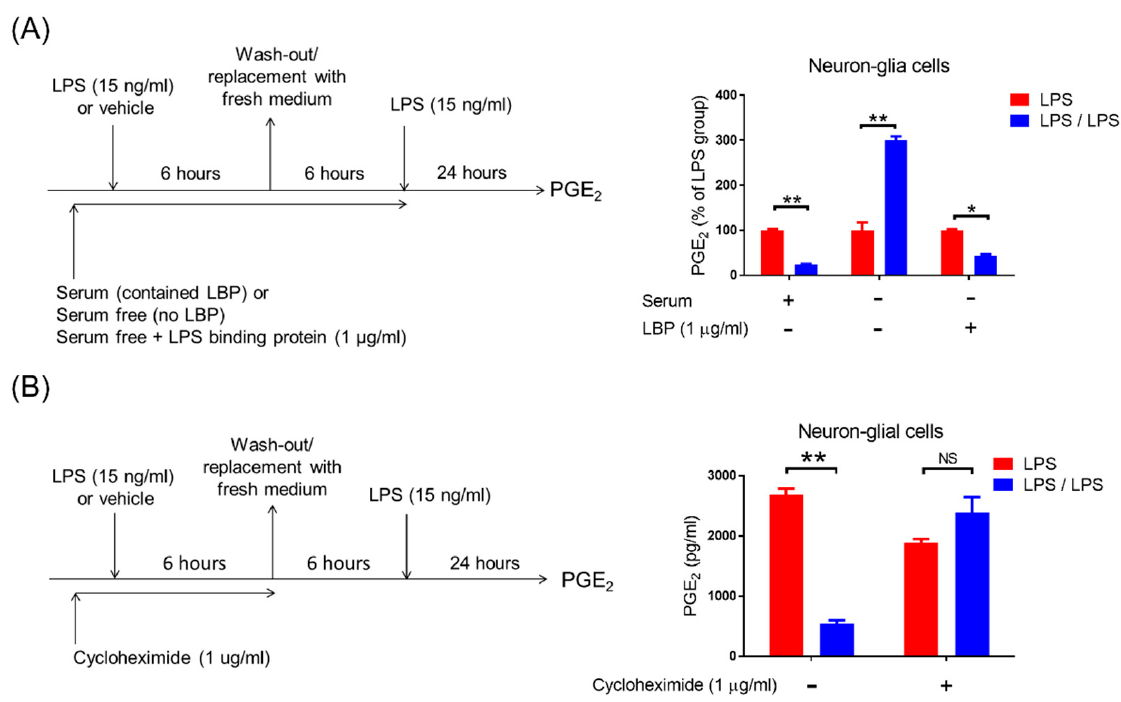
Figure 4. TLR4 signal and de novo protein synthesis is required for the development of PGE 2 tolerance in neuron–glial cells. ( A ) Left panel: Experimental procedure for studying the TLR4’s role in PGE 2 reduction during the endotoxin tolerance challenges. Right panel: Measurement of PGE 2 production in the NG cultures with or without endotoxin tolerance challenge (LPS-treated versus LPS/LPS-treated group) in the conditions of 10% serum medium, serum-free medium, or serum-free plus LBP (1 µ g/mL) at 24 h by ELISA. Data are expressed as the mean ± SEM from three independent experiments in duplicate, LPS group versus the LPS/LPS group. * p < 0.05, ** p < 0.01. ( B ) Left panel: Experimental procedure for studying the role of de novo protein synthesis in PGE 2 reduction in response to endotoxin tolerance. Right panel: After treatment with cycloheximide (1 µ g/mL) for 1 h, the NG cultures were applied to the procedure of the endotoxin tolerance challenge (LPS-treated versus LPS/LPS-treated group). PGE 2 level in the supernatant was detected 24 h after treatment by ELISA. Data are expressed as the mean ± SEM from three independent experiments in duplicate, LPS group versus the LPS/LPS group. ** p < 0.01, NS, not significant.